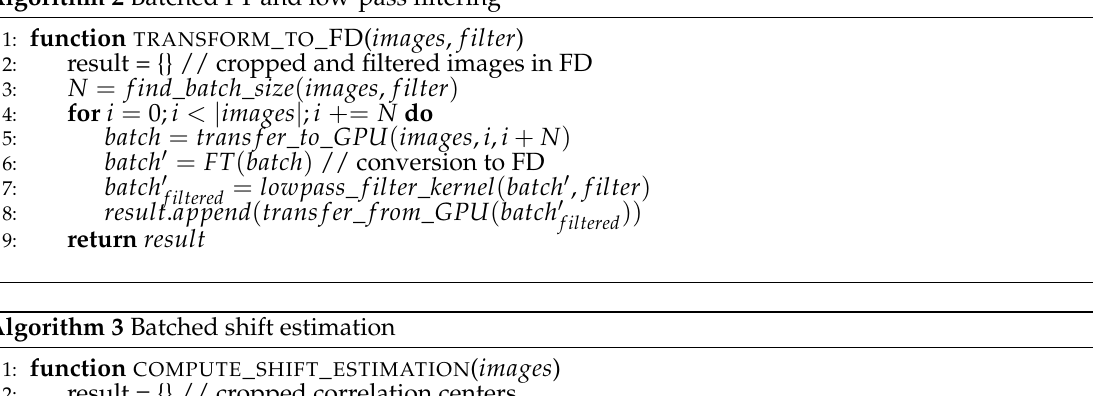
Algorithm 3 Batched shift